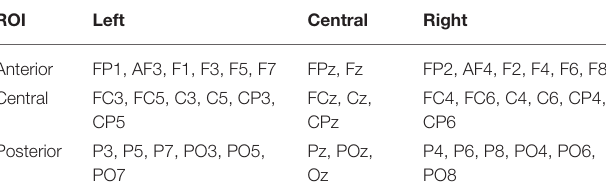
TABLE 1 | Electrode channels in each region of interest